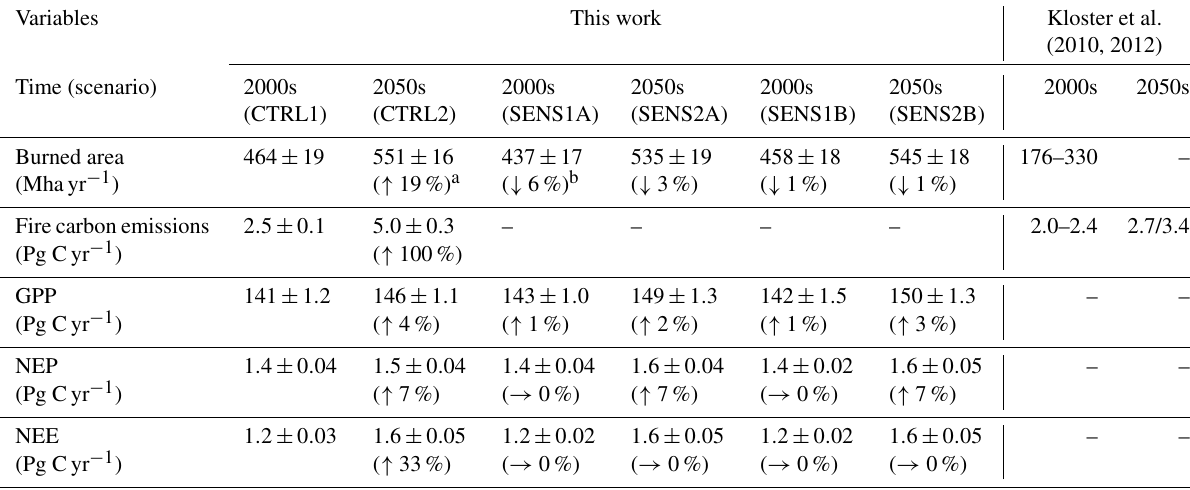
Table 5. Comparison of carbon budget variables between CESM-RESFire sensitivity experiments and previous studies.